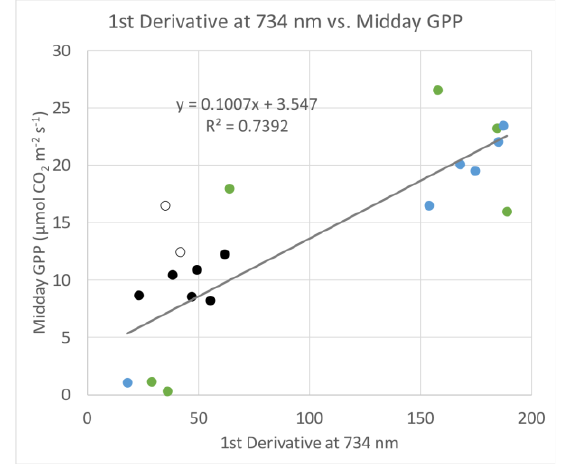
Figure 9 . First derivative at 734 nm from DESIS compared with midday GPP from flux towers. Point colors are described in Fig. 3 caption. Figure 7 . Correlations of the first derivative of the DESIS reflectance spectra compared with midday GPP from flux towers. Blue line shows the correlation values, orange line is a representative reflectance spectra (not scaled to y-axis) for orientation.